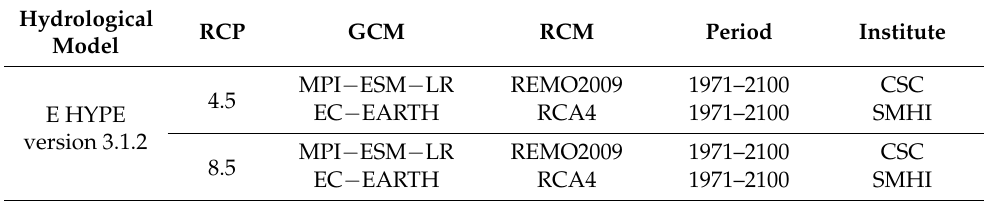
Table 1. Representative Concentration Pathways (RCP), General Circulation Models (GCM), and Regional Climate Models (RCM) were used in this study Hydrological RCP GCM RCM Model